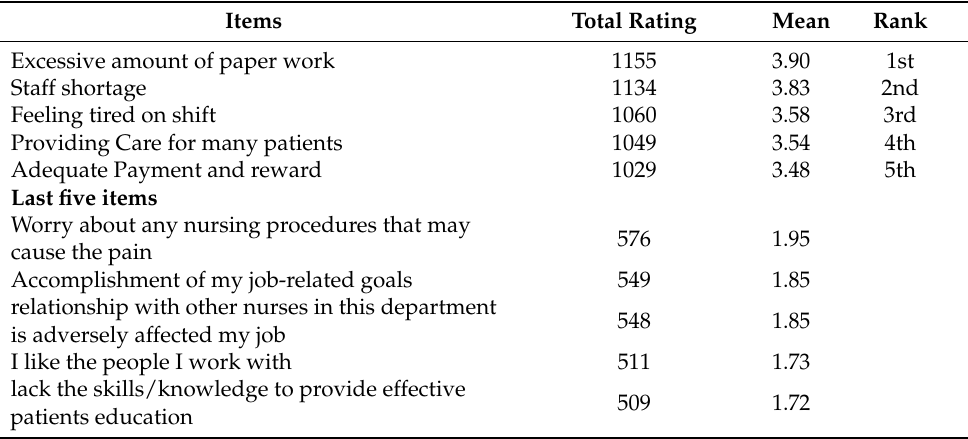
Table 3. Ranking of perceived stress sources ( n = 296).